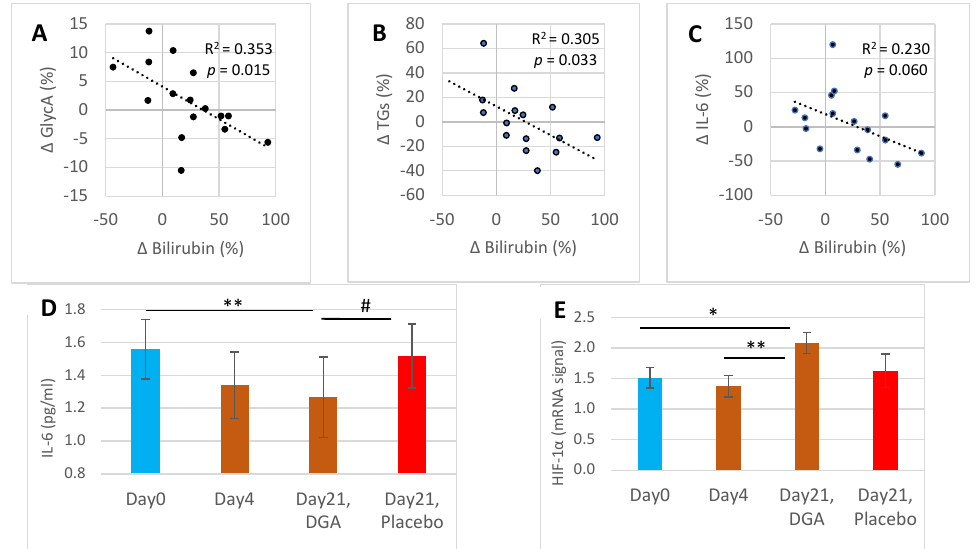
Figure 2. Bilirubin associated Day21 anti-inflammatory, fat metabolic, and mRNA expression effects: ( A ) scatter diagram and R 2 of the percent changes from Day0 to Day21 between GlycA and bilirubin, ( B ) scatter diagram and R 2 of the percent changes from Day0 to Day21 between blood triglycerides and bilirubin, ( C ) scatter diagram and R 2 of the percent changes from Day4 to Day21 between IL-6 and bilirubin, ( D ) mean ( ± SEM) blood IL-6 concentration, ( E ) mean ( ± SEM) mRNA expression of HIF-1 α from collected WBCs. Notes: (1) In ( D , E ), the Day21 DGA and placebo averages are indexed to Day0 so that Day21 fully reflects the change from Day0. (2) * and ** indicate paired t -test, # indicates non-paired t -test between the %-changes from Day0 to Day21. In ( A – C ), the p -values are based on an F-test. (3) One Day21 observation was deducted from ( B ) as an outlier. Additionally, one Day0 IL-6 observation was excluded from ( D ) when comparing the changes from Day0 to Day21 in the placebo group against the DGA